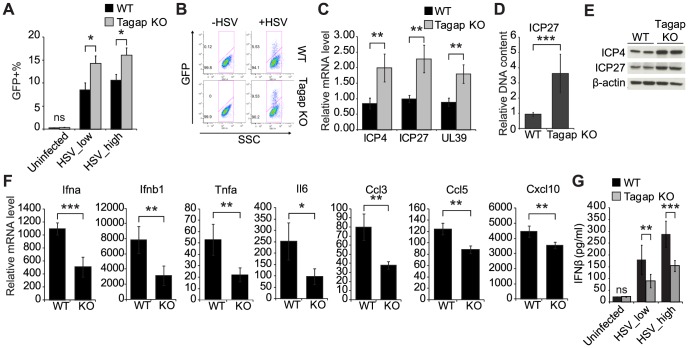
Tagap deficiency results in increased susceptibility to HSV-GFP infection in macrophages.(A and B) BMDMs derived from WT or Tagap−/− mice were infected with HSV-GFP at a MOI of 0.2 (HSV_low) or 0.5 (HSV_high). After 12 h, cells were harvested and stained for GFP. Experiments were performed with a total of 4 mice per genotype. Representative flow plots are shown in (B). ns, not significant; *P = .0463 for HSV_low; *P = 0.0370 for HSV_high. (C) BMDMs were infected with HSV-GFP at a MOI of 0.5. After 10 h, relative mRNA levels of three viral genes (ICP4, ICP27, and UL39) were measured in WT versus Tagap−/− BMDMs. Gapdh was used as internal control for normalization. n = 2 with a total of 4 mice per genotype. **P = 0.0032 for ICP4; **P = 0.0013 for ICP27; **P = 0.0014 for UL39. (D) BMDMs were infected with HSV-GFP at a MOI of 0.5. After 16 h, DNA was isolated and the relative DNA content of ICP27 in WT versus Tagap−/− BMDMs was measured. Rplp0 DNA content was used as internal control for normalization. n = 2 with a total of 4 mice per genotype. ***P<0.0001. (E) BMDMs were infected with HSV-GFP at a MOI of 0.5. After 24 h, Western blotting was performed using antibodies specific to viral proteins ICP4 and ICP27. β-actin was used as loading control. Representative image from two independent experiments is shown. (F) BMDMs were infected as in C. After 3 or 6 h, RNA was isolated to measure the relative expression of pro-inflammatory cytokines or chemokines, respectively. n = 2 with a total of 4 mice per genotype. ***P = 0.0006 for Ifna; **P = 0.0052 for Ifnb1; **P = 0.0063 for Tnfa; *P = 0.0123 for Il6; **P = 0.0014 for Ccl3; **P = 0.0011 for Ccl5; **P = 0.0052 for Cxcl10. (G) BMDMs were infected as in (A). After 12 h, culture supernatant was collected and ELISA was performed to measure the amount of secreted IFN-β. n = 3 with a total of 6 mice per genotype. ns, not significant; **P = 0.0094 for HSV_low; ***P = 0.0003 for HSV_high. All statistical comparisons were performed by unpaired two-tailed t-tests.